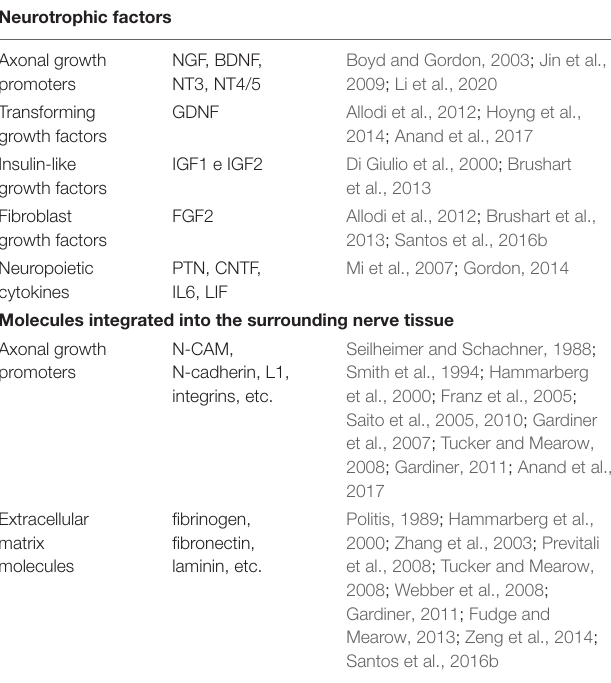
TABLE 1 | Neurotrophic and neurotropic molecules that are expressed by the Schwann cells in the distal endoneural tubes. Neurotrophic factors